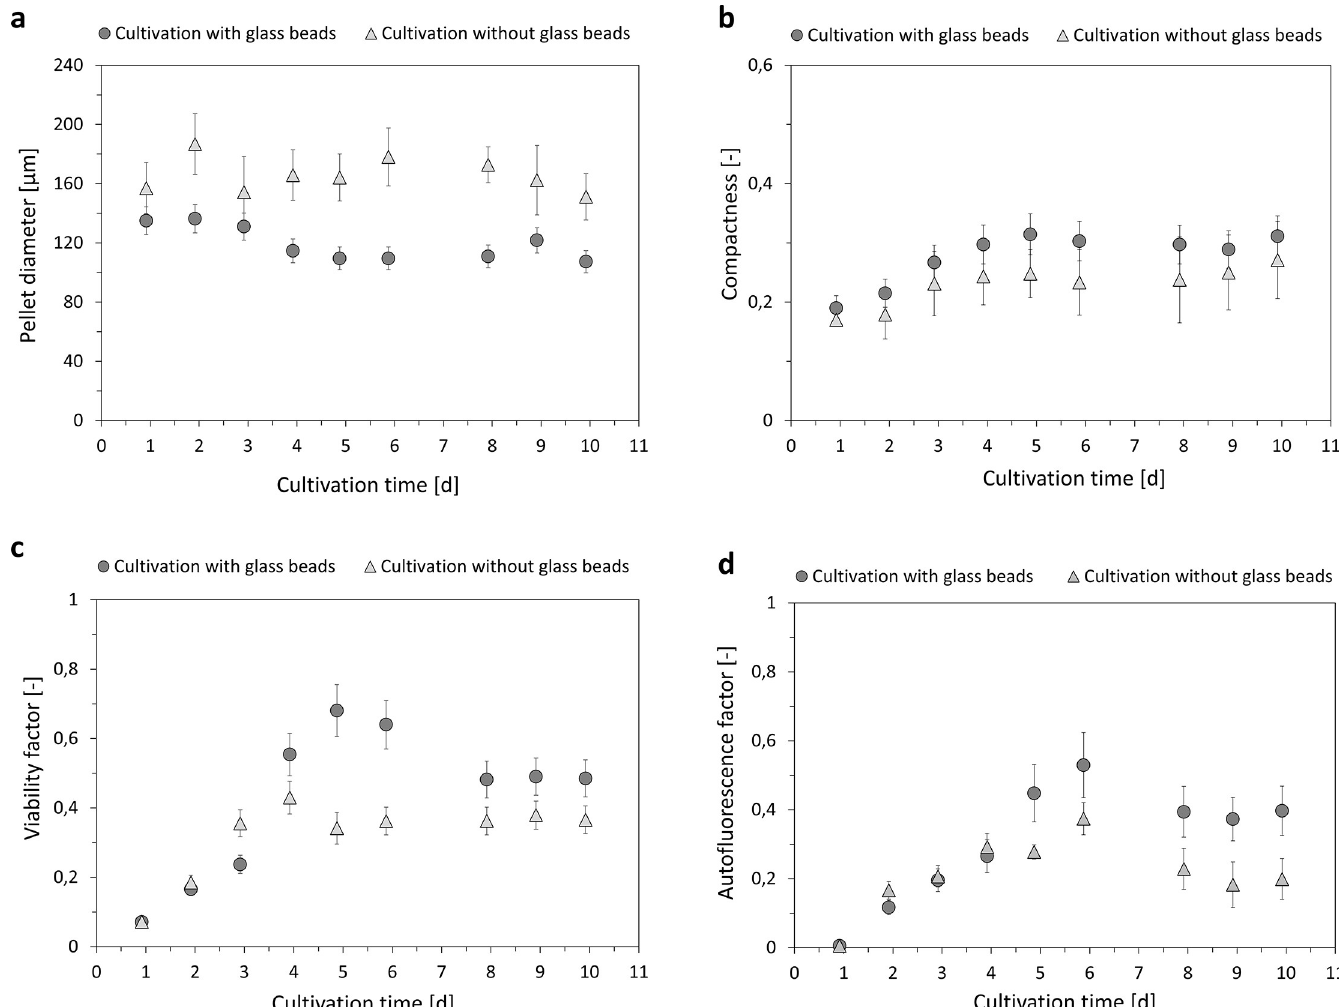
Fig 7. Comparison of results from analysis of flow cytometry between cultivations with (circle) and without glass beads (triangle): (a) Pellet diameter derived from signal length, (b) compactness (Eq (5)), (c) viability factor (Eq (8)) and (d) autofluorescence factor (Eq (9)) over cultivation